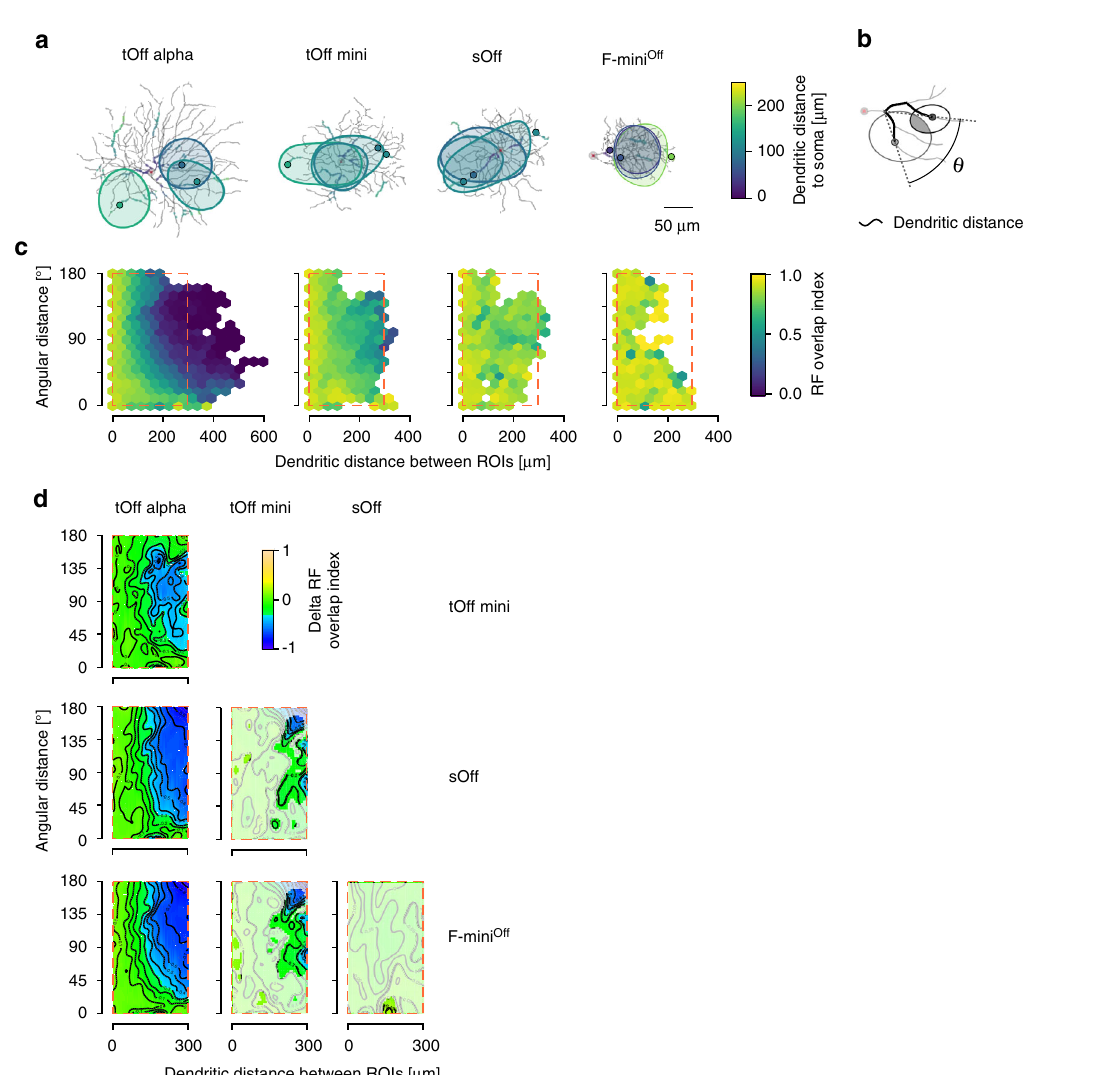
Fig. 4 Dendritic RF overlap. a Top-views of the different reconstructed RGC types with RF contours of three ROIs overlaid. b , Illustration of dendritic and angular distance ( Ѳ ) between two ROIs (measured from the last common branching node) and RF overlap (grey area) of two RF contours (ellipses). c Hexagon maps showing the dendritic RF overlap index (colour-coded) as a function of Ѳ and dendritic distance for all ROI pairs: tOff alpha ( n = 17\40,777 cells\ROI pairs), tOff mini ( n = 5\13,524), sOff ( n = 4\3141), and F-mini Off ( n = 5\2097). d 2D comparison maps for plot area marked by the dashed red rectangles in c for each pair of RGC types. Colour codes difference in RF overlap index, with whitened areas indicating no signi fi cant difference. For details, see Supplementary Statistical